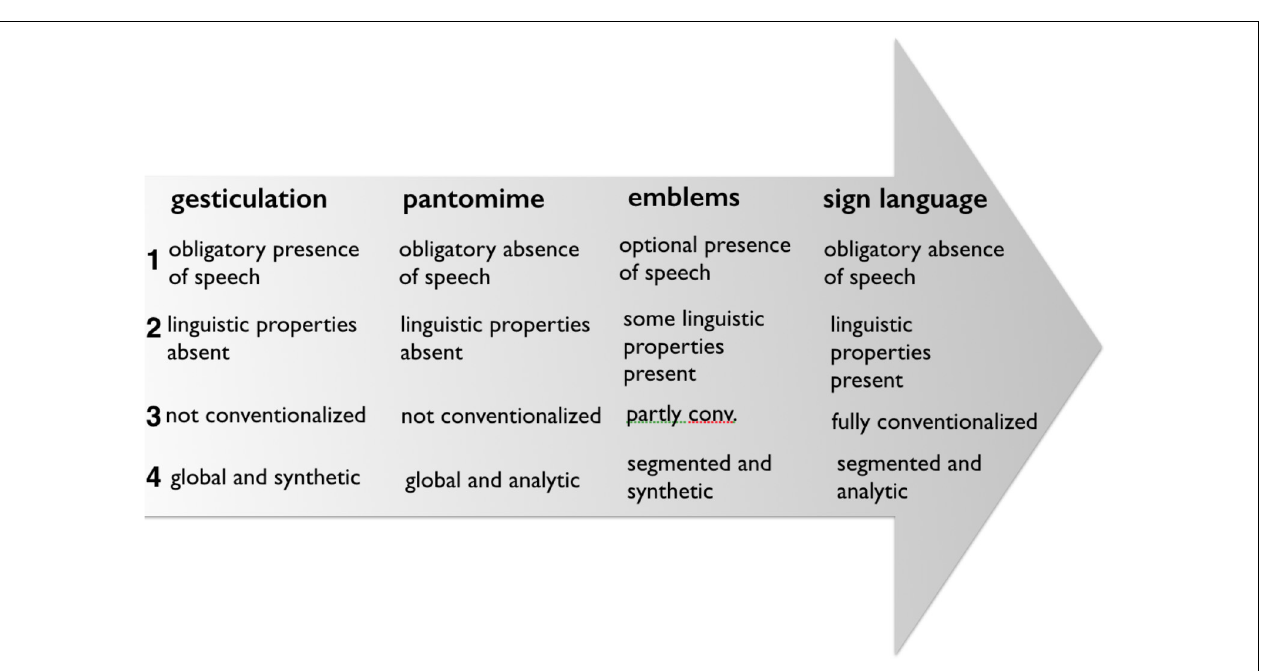
Frontiers in Psychology |